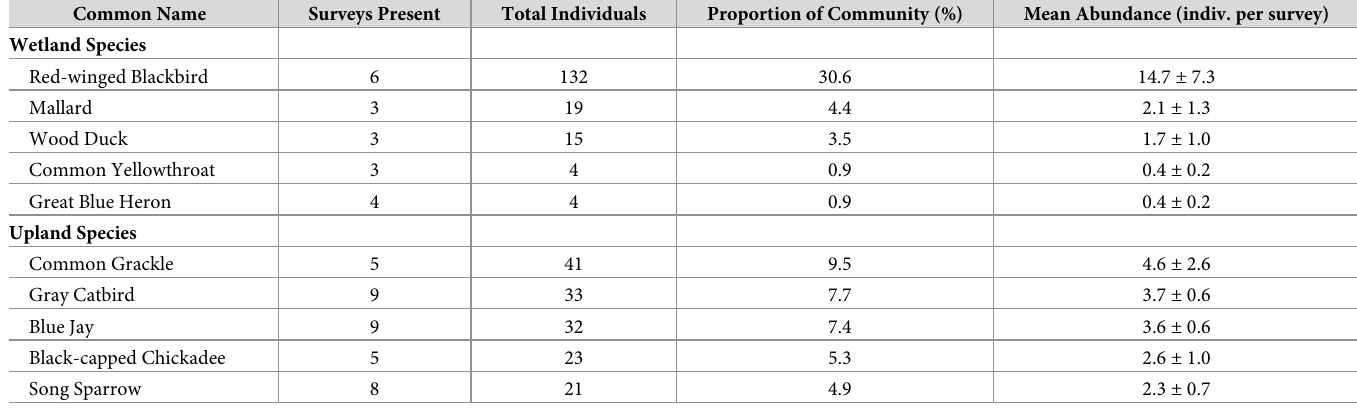
Table 8. The five most common wetland (dependent and associated) and upland species of the avian community monitoring in